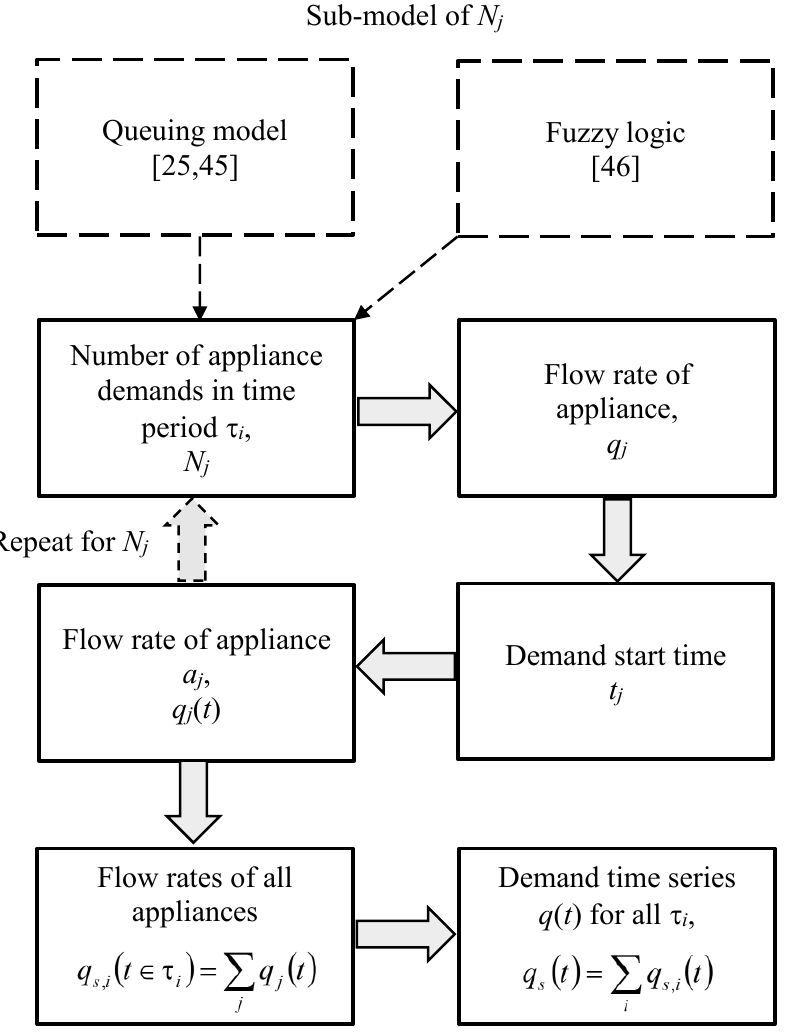
Figure 5. Simulations for time series of simultaneous demands.